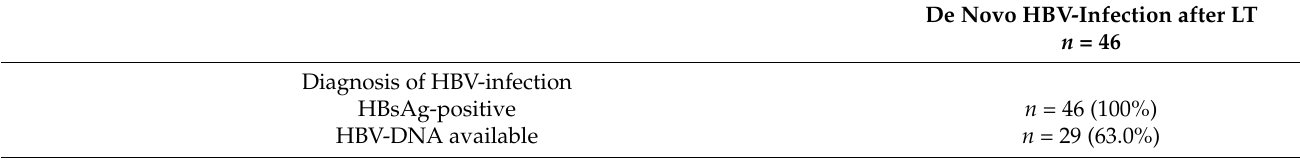
Table 2. Parameters at time of diagnosis/treatment initiation of de novo HBV-infection after